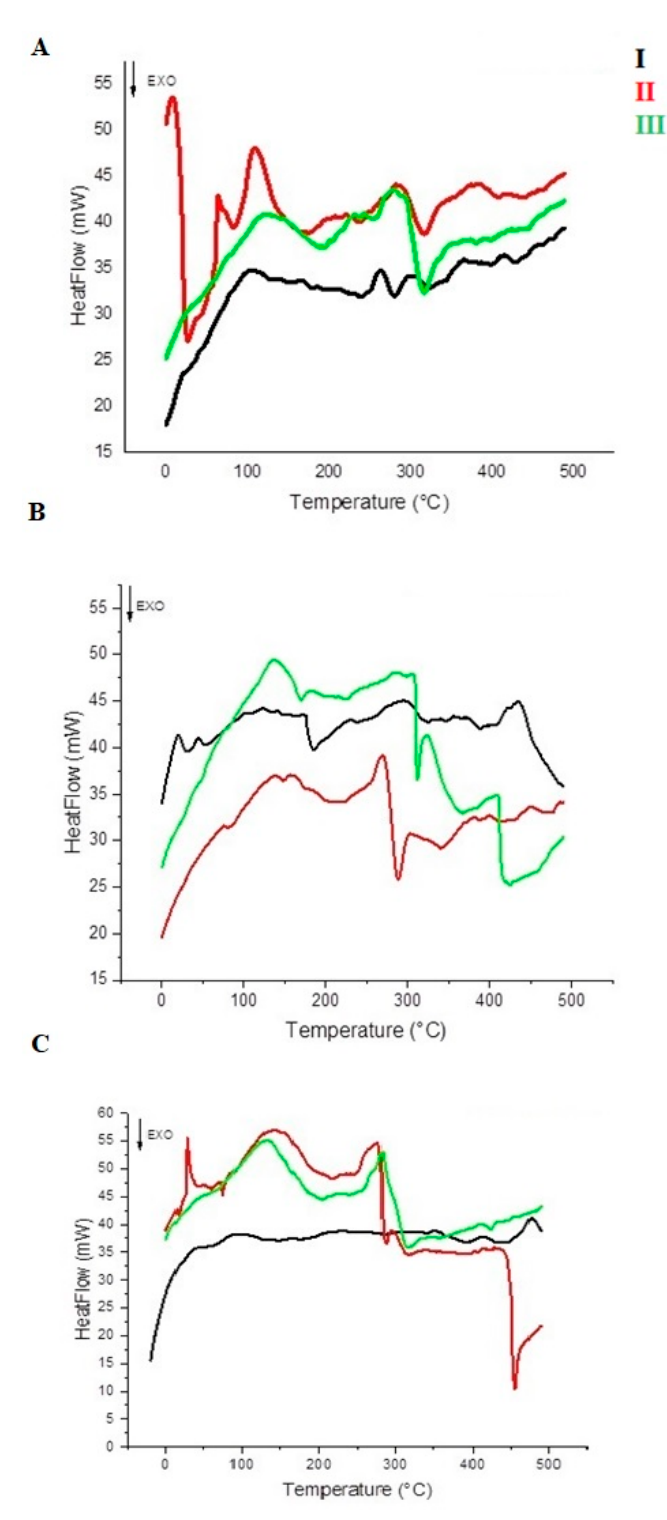
Figure 6. Differential scanning calorimetry of cow ( A ), buffalo ( B ) and goat ( C ) kefirans extracted with cold water (black line), hot water (red line), and mild heat ‐ ultrasound (green line). with cold water (black line), hot water (red line), and mild heat-ultrasound (green